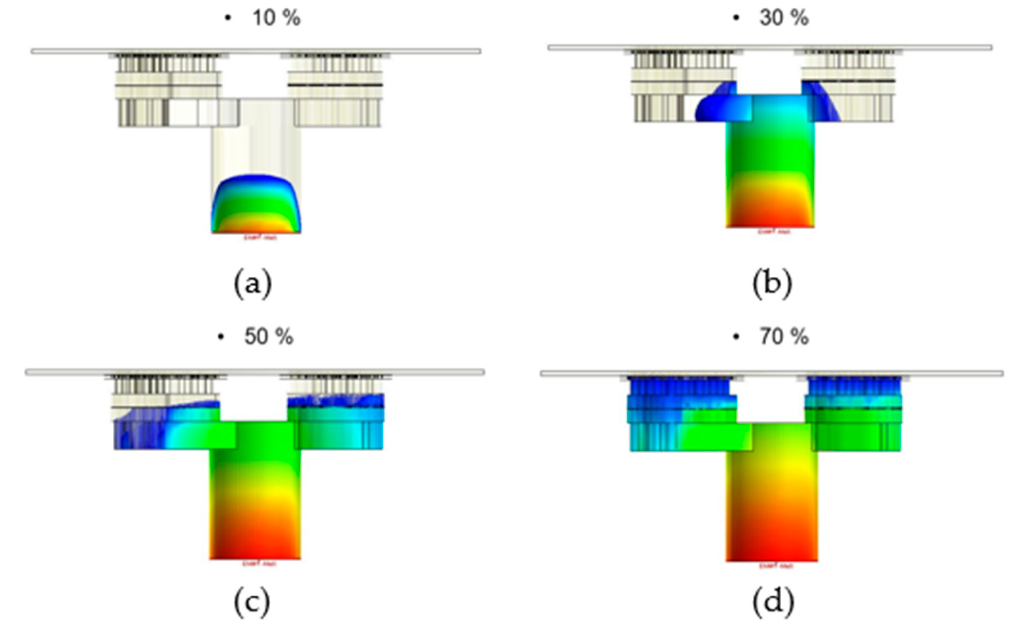
Figure 12. The flow front of the runner with a flow rate of 0.14 cm 3 /sec in Case 2. ( a ) Filling 10%; ( b ) filling 30%; ( c ) filling 50%; and ( d ) filling 70%.